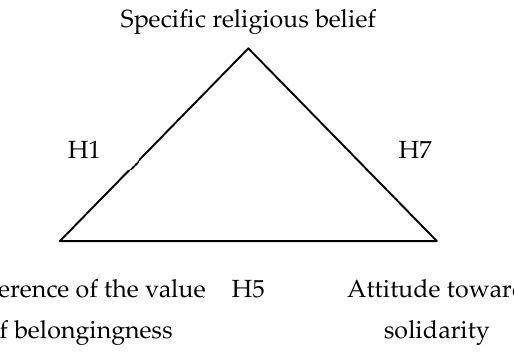
Figure 4. Relationships of solidarity attitudes.